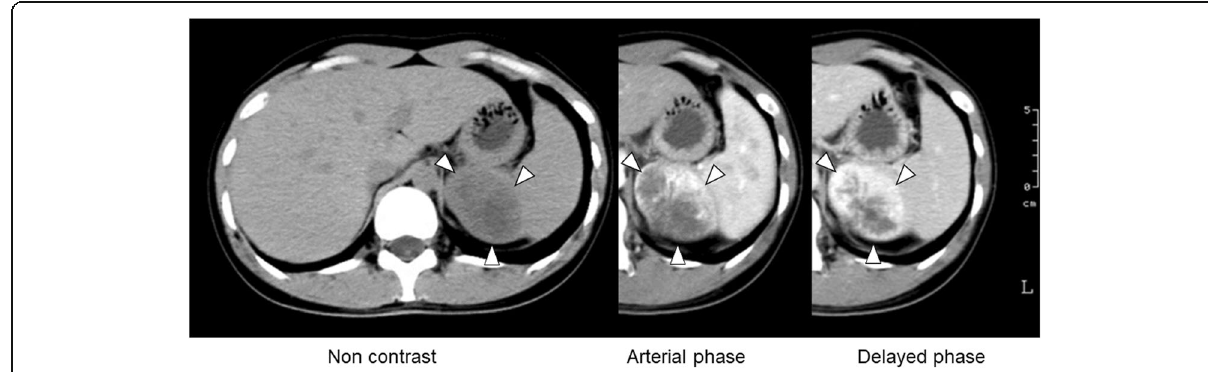
Fig. 1 Contrast-enhanced computerized tomography (CT) image. Enhanced computed tomography confirmed the presence of a solid mass measuring about 6 cm with well-defined and regular borders in the retroperitoneum. Peak contrast enhancement in a part of the tumor was seen in the delayed